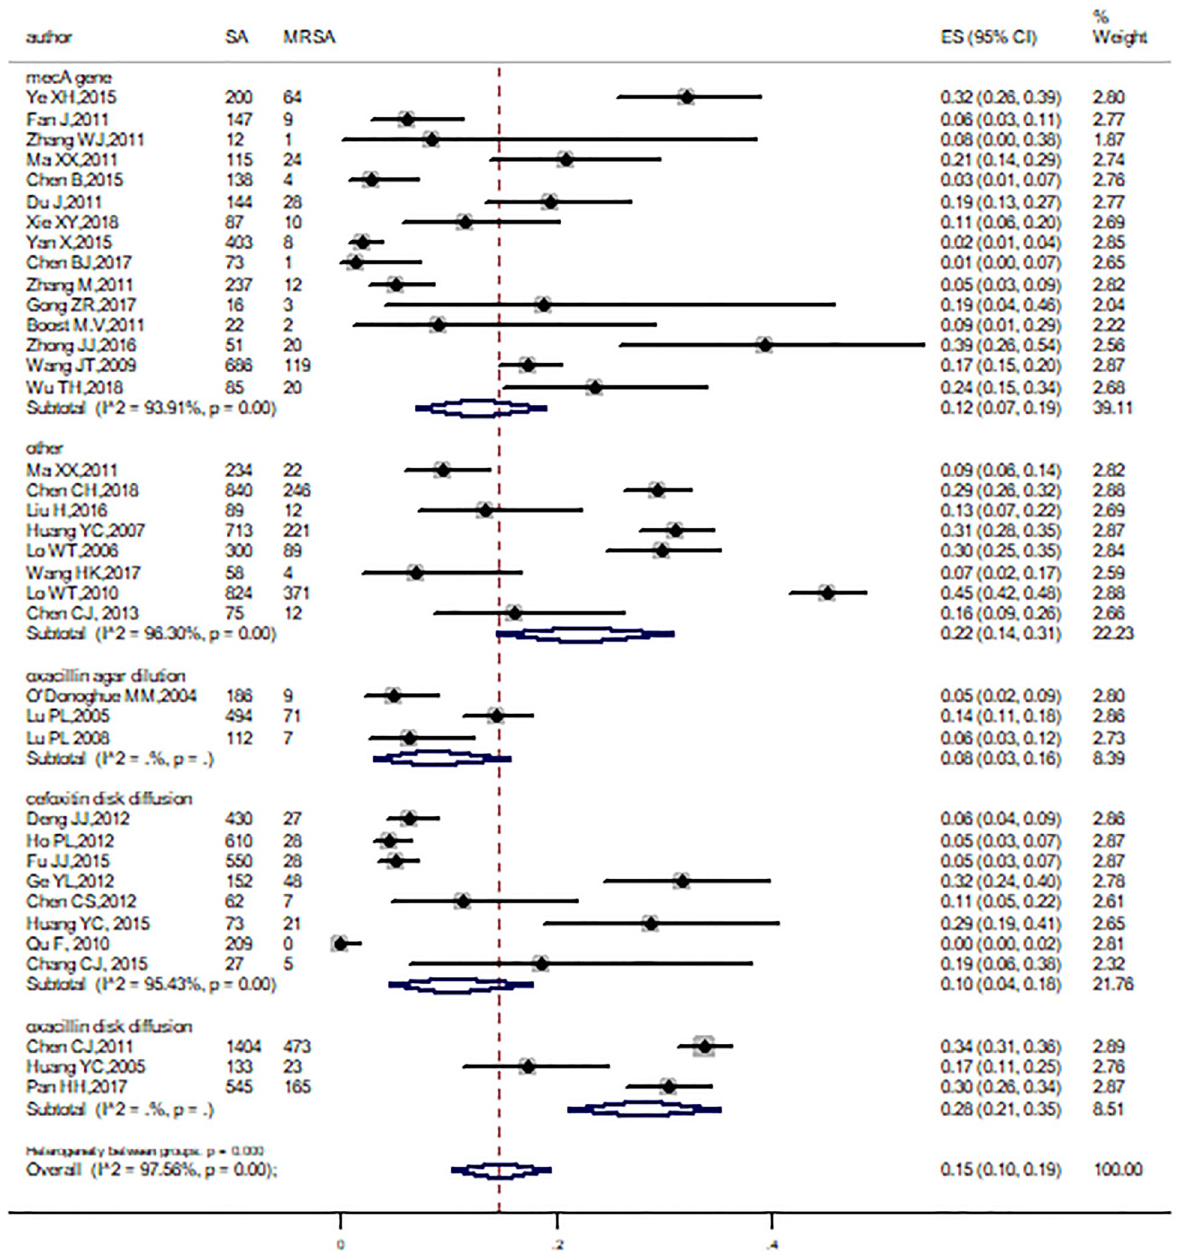
Fig 6. Subgroup analysis for the prevalence of MRSA by methods identification of